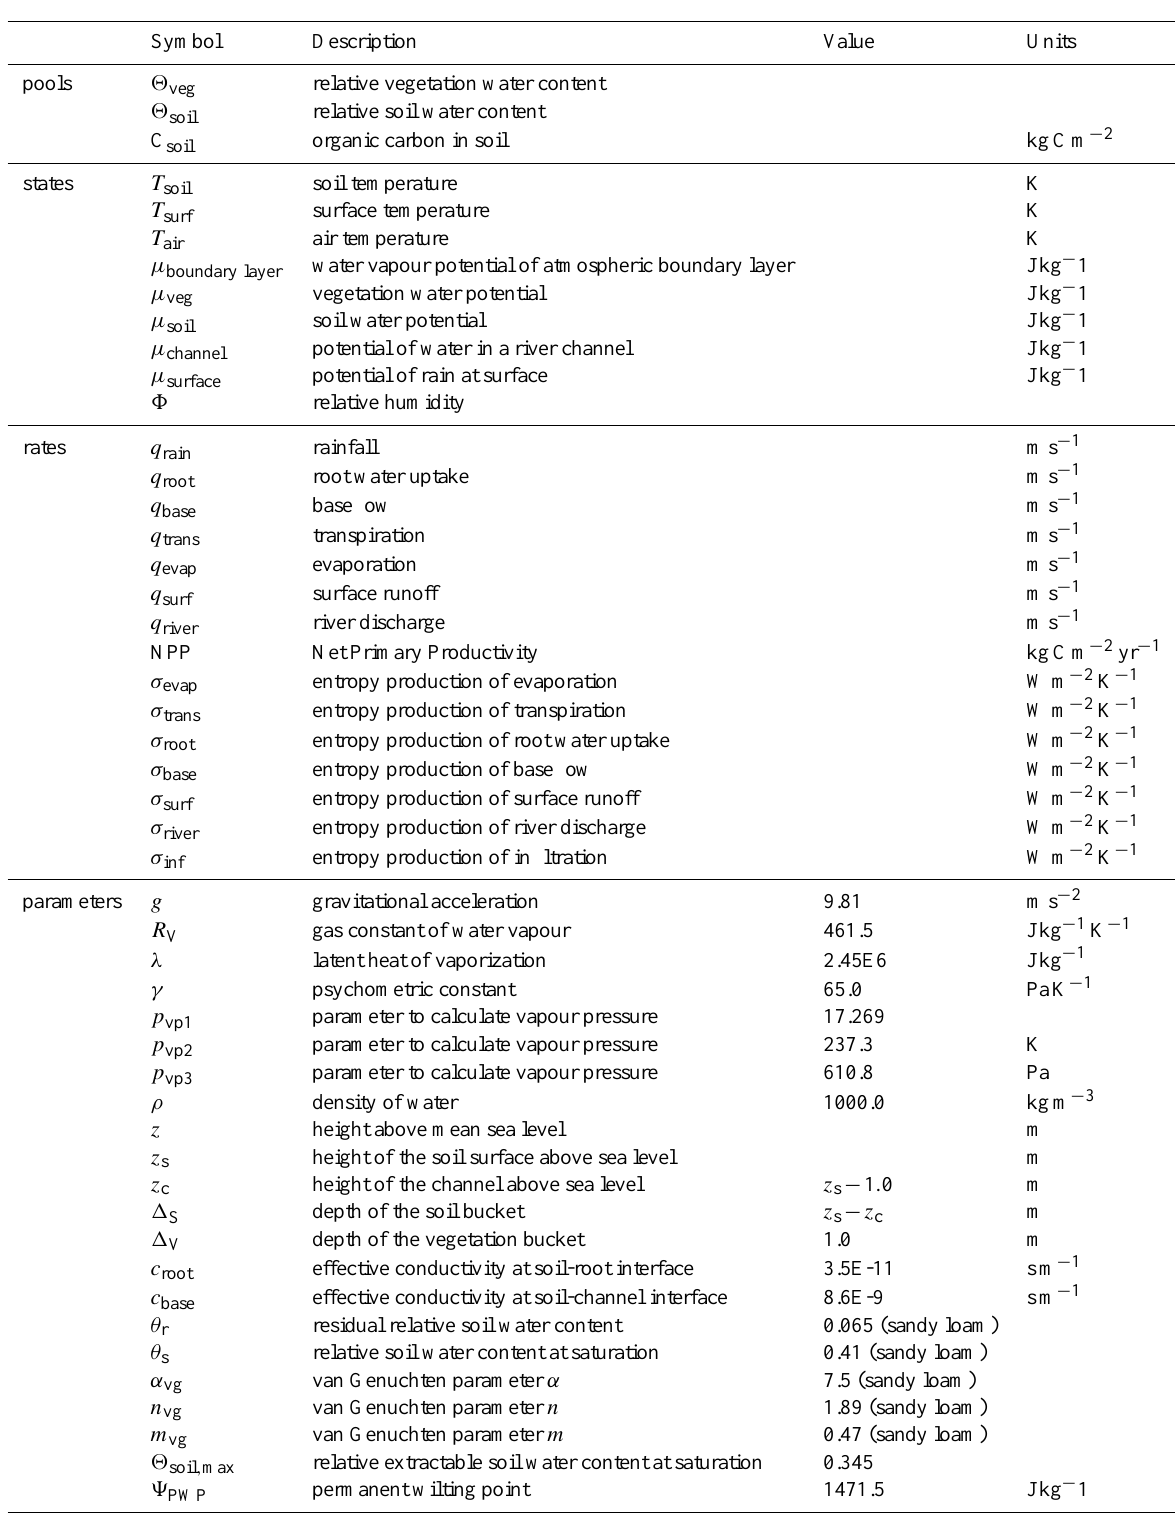
Table A1. Description of model variables and parameters. Symbol